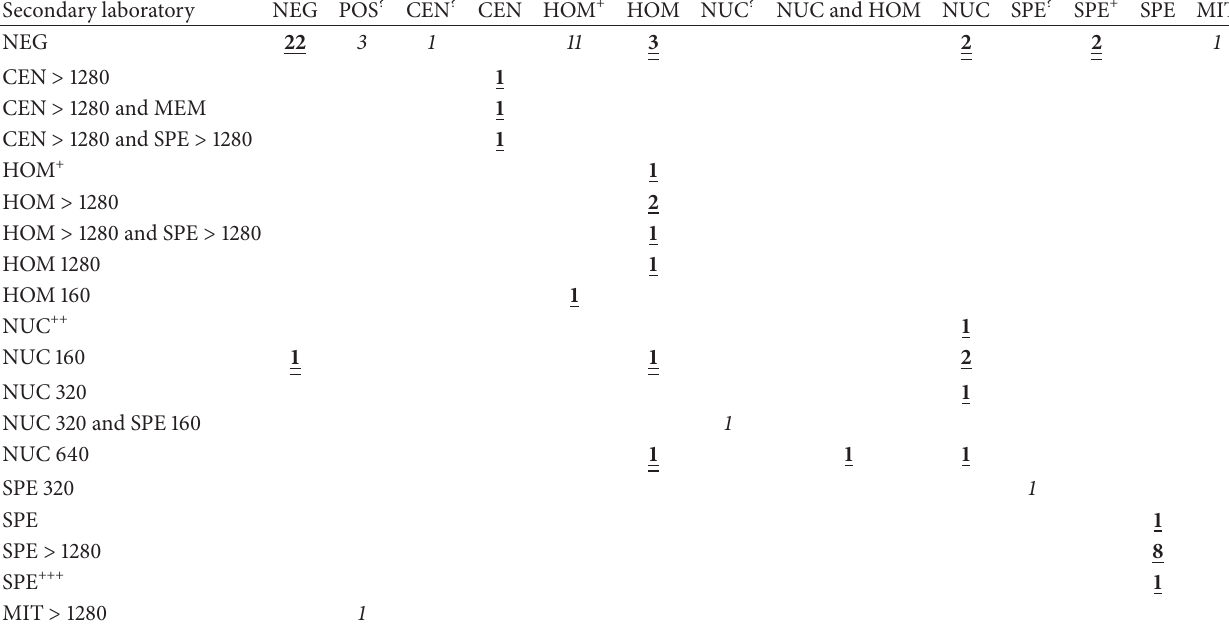
Primary laboratory: Gentofte Hospital, and secondary laboratory: Statens Serum Institut; NEG: negative; POS: positive; CEN: centromere; HOM: homogeneous; NUC: nuclear; SPE: speckled; MIT: mitochondria; ?: uncertain reaction; +: weak reaction; ++: intermediate reaction, and +++: strong reaction. Underlining and bold font indicate agreement, italics indicate acceptable agreement, and double underlining indicates disagreement.